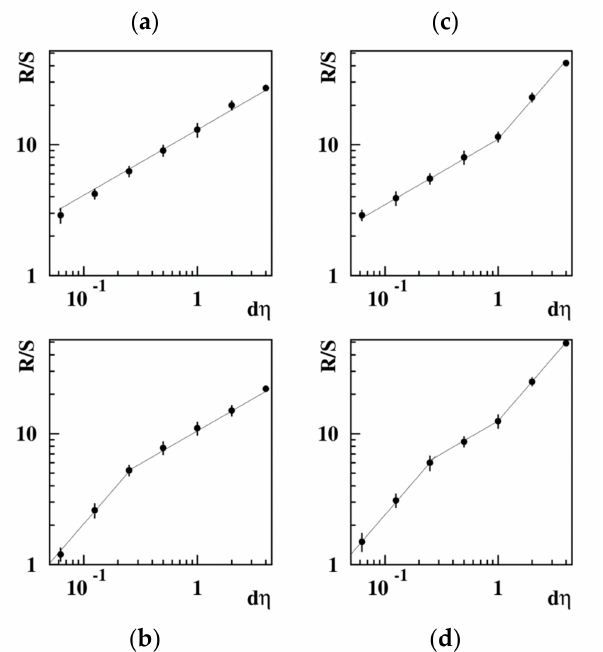
Figure 6. Behavior of the Hurst curve for four types of events Au + Em 10.6 AGeV: ( a )—uncorrelated, ( b )—with short-range correlations, ( c )—with long-range correlations, ( d